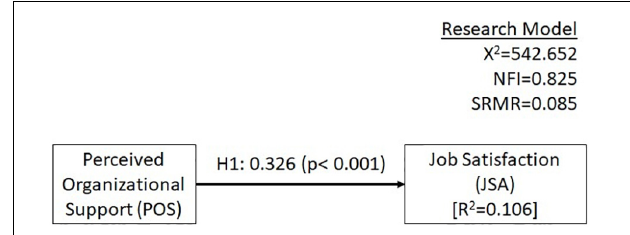
FIGURE 2 | Results of structural model analysis (sample N =